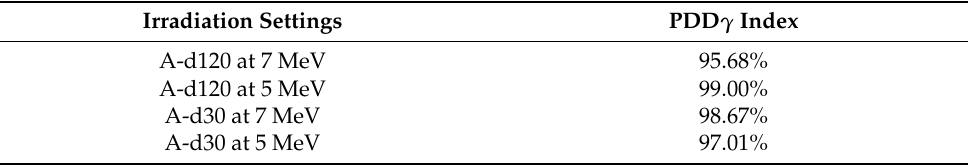
Table 5. Gamma index analysis for PDD, performed with 3% 3 mm threshold.